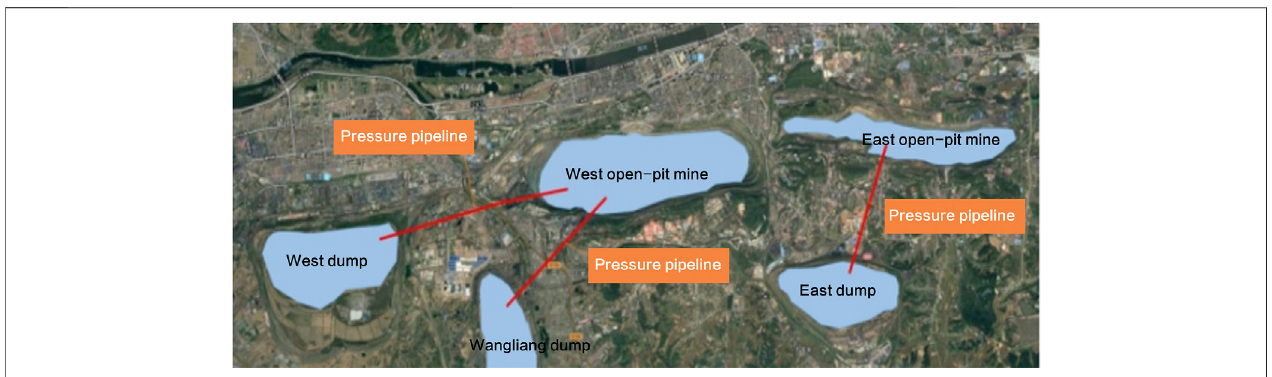
FIGURE 7 | The multi-pit and dump linkage energy storage mode.